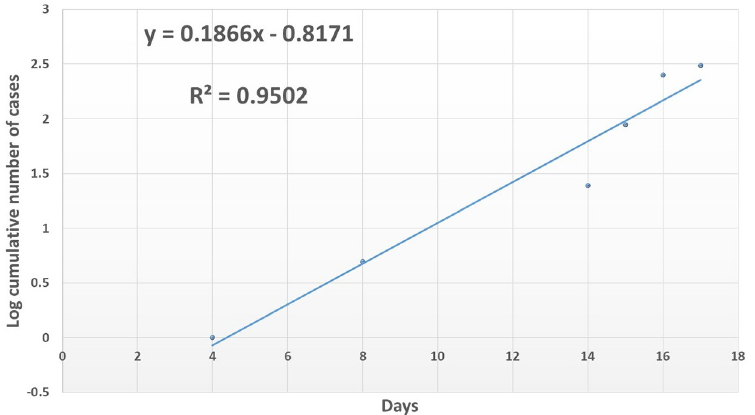
Fig 4. Log cumulative number of cases plotted against time and the fitted linear regression model for segment of initial rise of cases during the 2015 Nyimba district bubonic plague outbreak (R 2 value of 0.9502 for the fitted linear model equally accepted as significant).